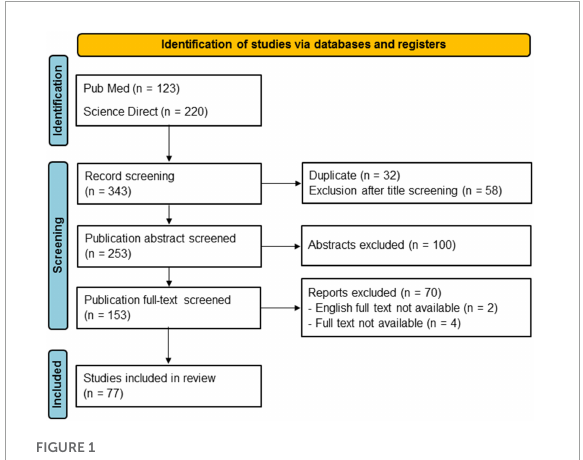
FIGURE1 PRISMA flowchart of the systematic review on the right frontal aslant tract (FAT).